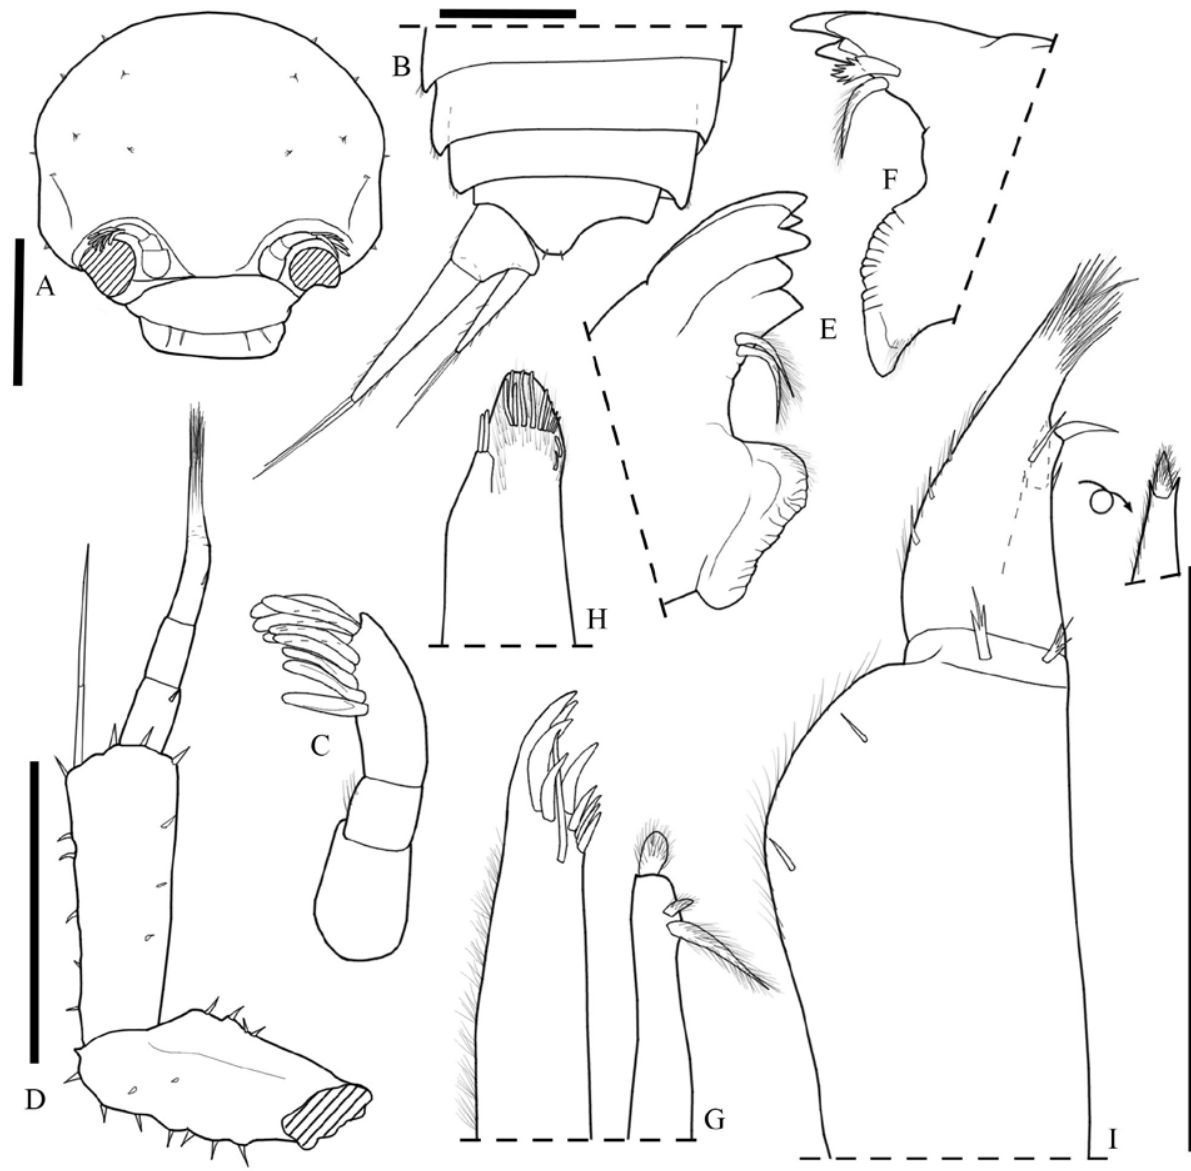
Figure 5. Pectenoniscus juveniliensis n. sp. Male paratype: A , cephalon, frontal view; B , pleotelson and uropod, dorsal view; C , antennula; D , antenna; E , left mandible; F , right mandible; G , maxillula; H , maxilla; I, maxilliped. Scale bars: 0.2